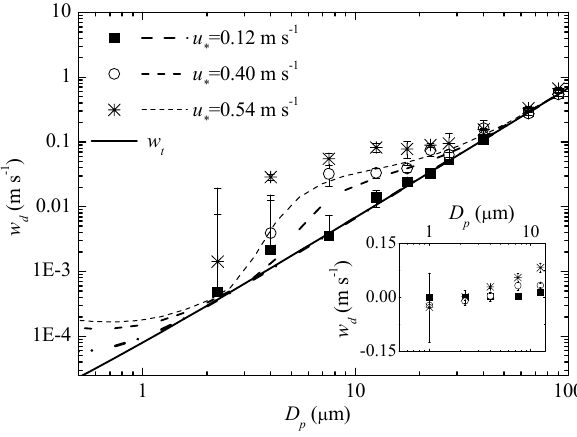
Figure 10. Deposition velocity against particle size under different wind conditions over the wood surface. The dots are averaged w d and the error bars represent the variability of the three runs. The curves are the results predicted with the SS80 scheme. The height of the measuring point is 15mm above the wood surface. w d for small particles (1–12.5µm) have been inserted in the lower right corner to display the possible negative deposition velocities which impossibly appear in logarithmic coordinate system.